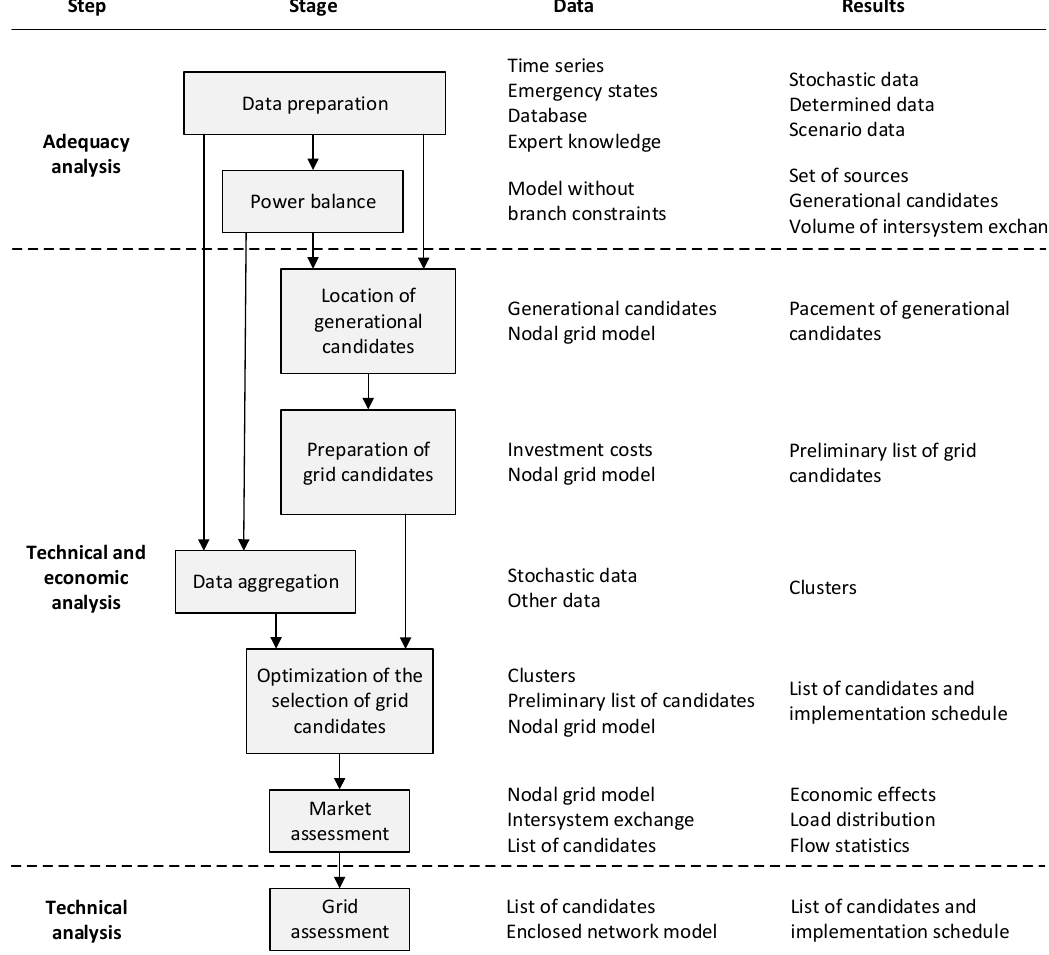
Figure 3. The cycle of successive stages of the TEP development.